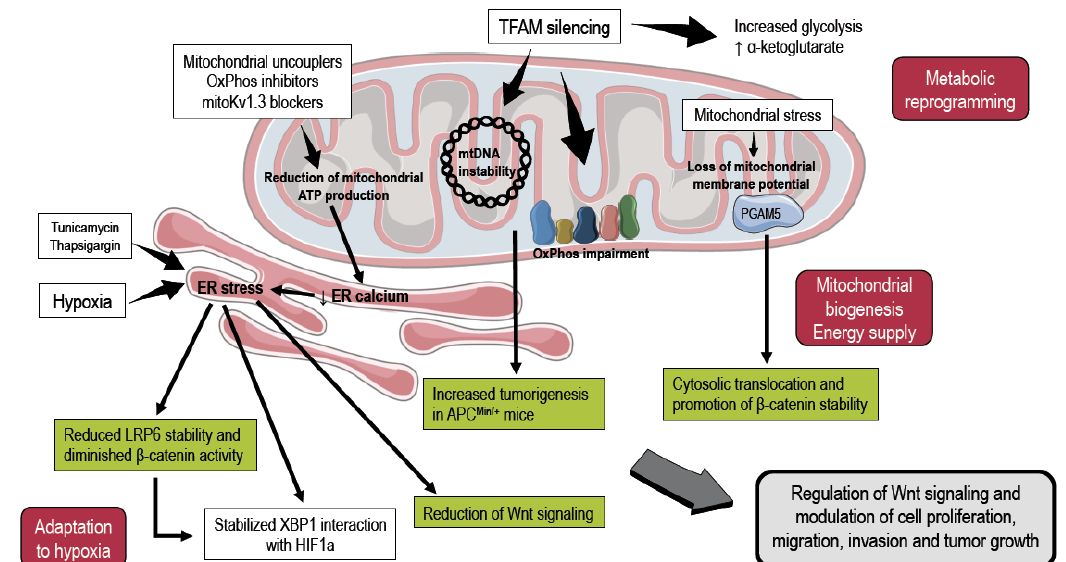
Figure 2. Interplay between mitochondria and Wnt signaling. Mitochondria can modulate intracellular signaling in different ways. ER stress induced by hypoxia or reduced ATP production in mitochondria leads to a decrease in β -catenin stability and a subsequent reduction in Wnt signaling. On the other hand, the loss of mitochondrial membrane potential can induce the translocation of PGAM5 into the cytosol, where it promotes β -catenin stability. TFAM, a mitochondrial transcription factor, is also thought to contribute to the complex regulation of Wnt signaling by mitochondria. All these events are important factors that allow a dynamic regulation of intracellular signaling. For further details, please refer to the text. This figure was created using images from Servier Medical Art (http://smart.servier.com). Servier Medical Art by Servier is licensed under a Creative Commons Attribution 3.0 Unported License.